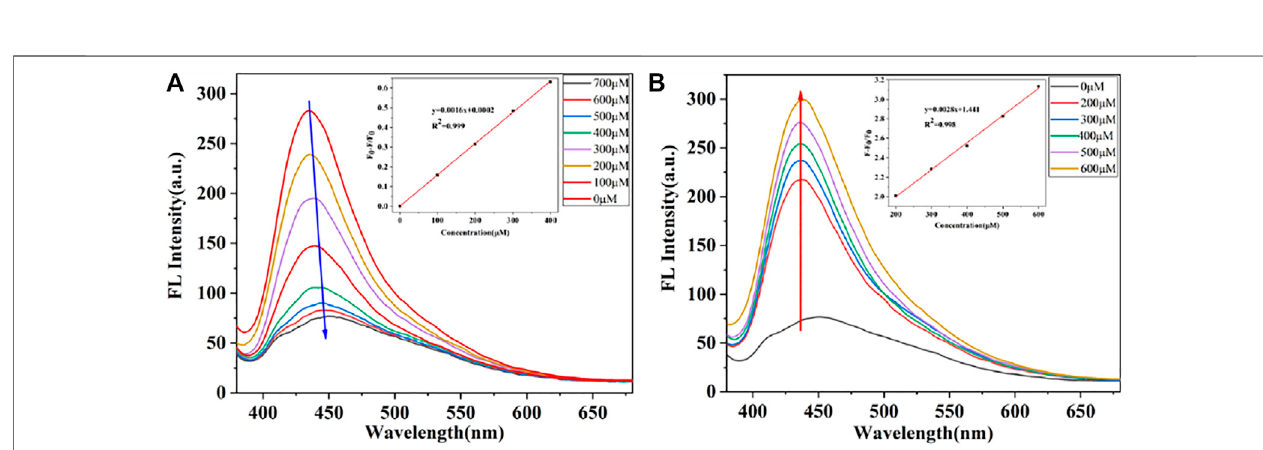
FIGURE5|(A) FluorescencespectraofCDsinthepresenceofdifferentconcentrationsofNO 2- .Insert:Linearrelationshipbetween(F 0 -F)/F 0 andtheconcentration of NO 2- (B) Fluorescence recovery of the CDs with various SO 32- concentrations. Insert: Fitted line between (F-F 0 )/F and the concentration of SO 32- .